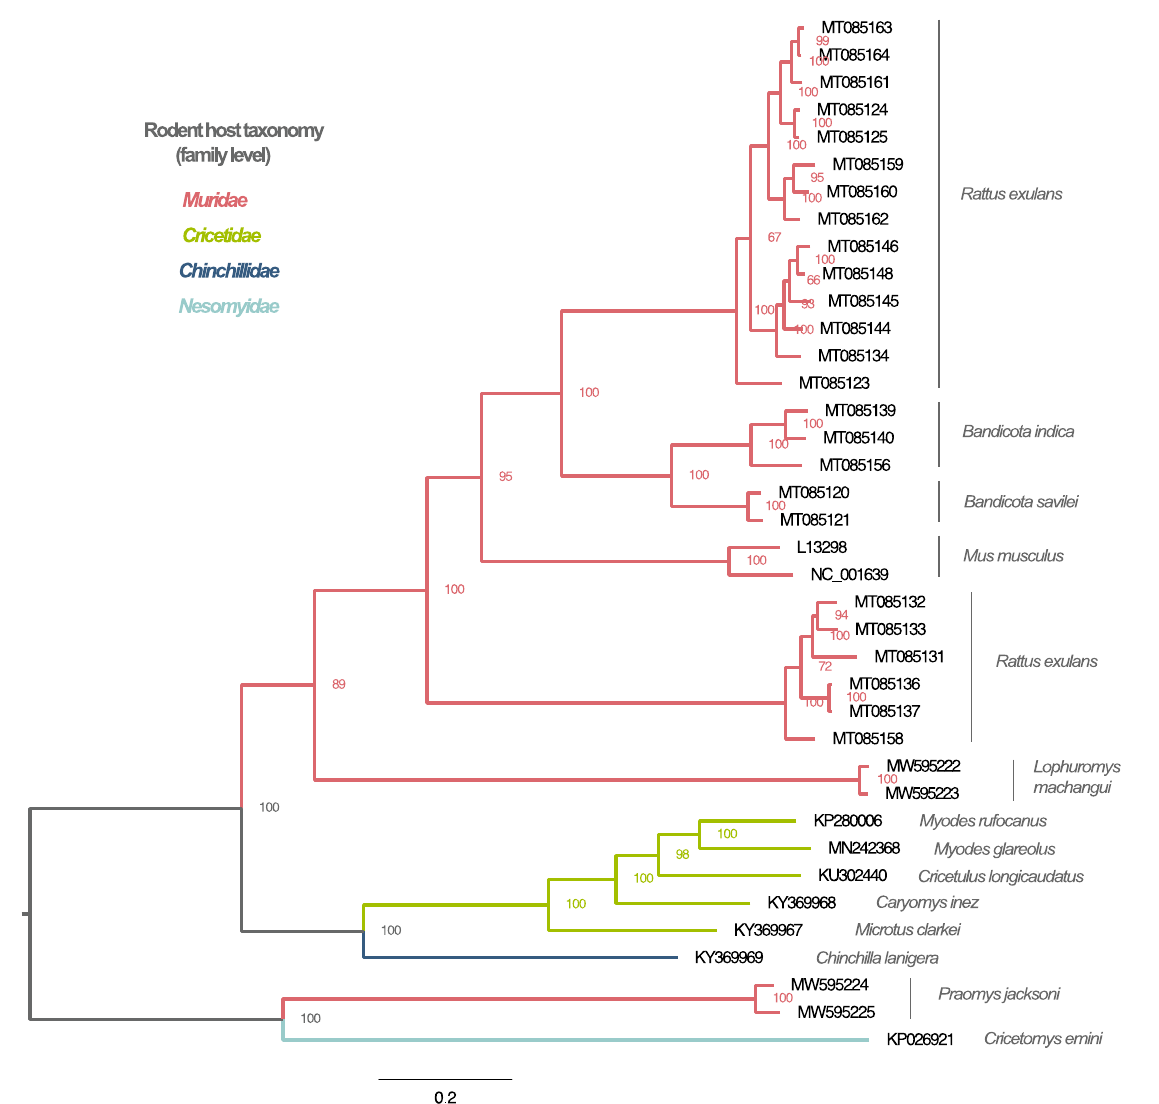
Figure 3. Phylogenetic reconstruction of the rodent-borne arteriviruses. Maximum likelihood phylogenetic tree based on the ORF1ab of all rodent arteriviruses for which coding-complete genomes are available. Numbers next to the internal nodes indicate bootstrap support, while branch colors denote taxonomically assigned rodent families. Descriptions in grey italics correspond to rodent species * . Phylogenetic clustering shows that rodent-borne arteriviruses group together at a rodent family level with only the Praja virus variants not following this pattern. (* footnote: For the rodent arteriviruses with GenBank accession numbers KY369968 and KY369967, the original GenBank submission file listed their hosts as “ Eothenomys inez ” and “ Neodon clarkei ”, respectively. To be consistent with the most up-to-date mammalian taxonomy, these species names were replaced by their homotypic synonyms, which are the “ Caryomys inez ” and the “ Microtus clarkei ”, respectively).